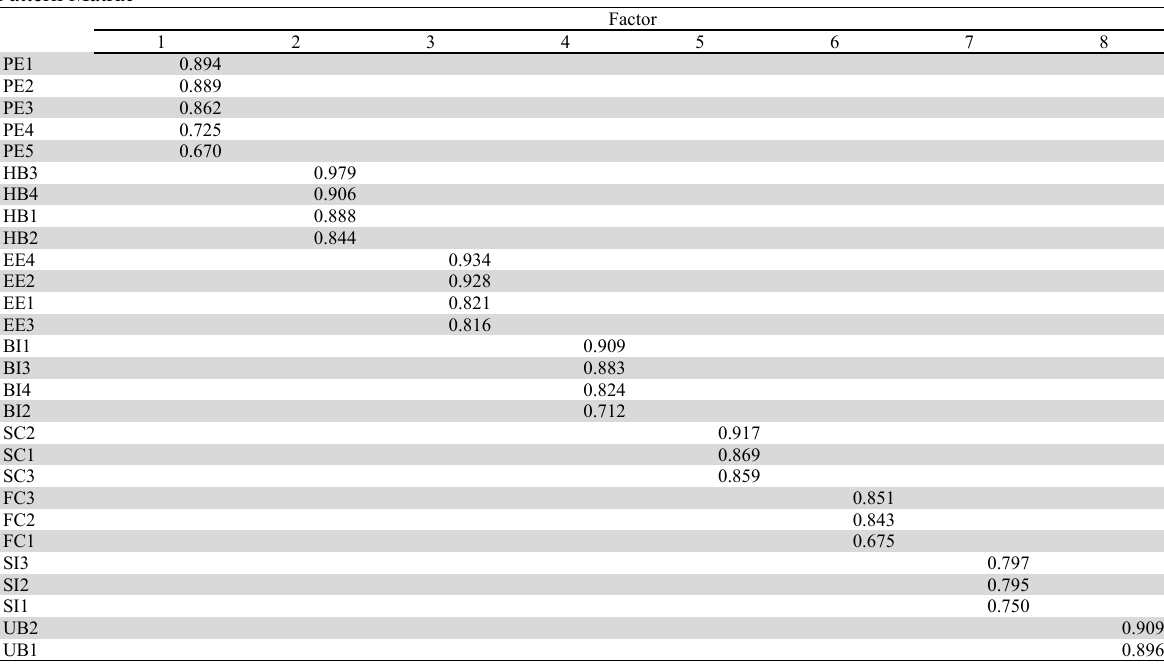
Pattern Matrix a